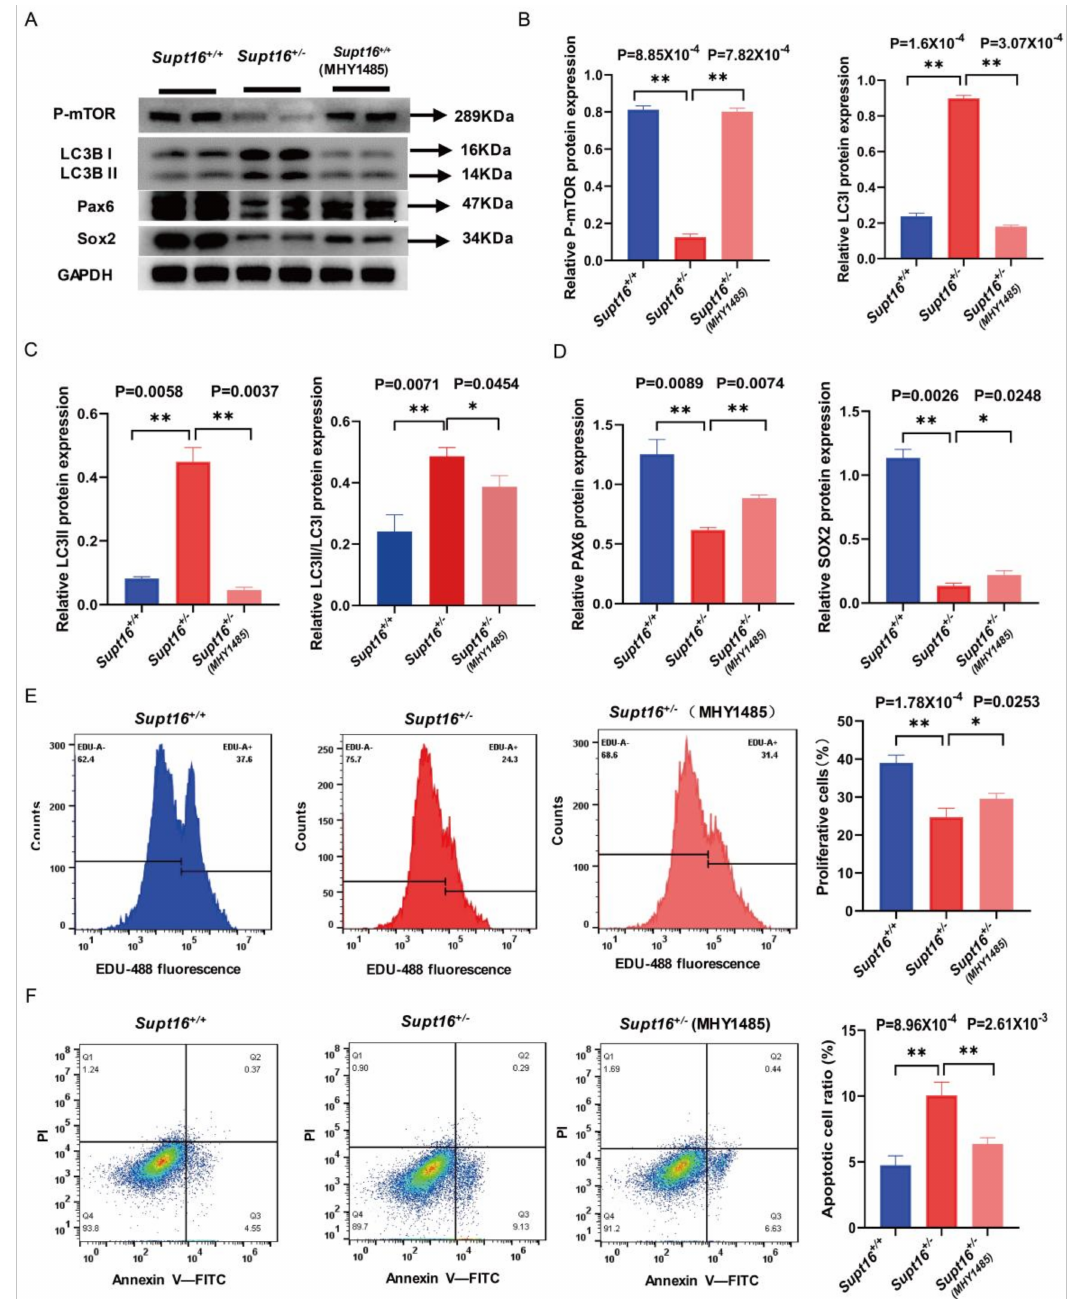
Figure 4. MHY1485 treatment rescued the phenotypes of Supt16 haploinsufficient hNSCs. ( A ) Western blot analysis showed the protein expressions of P − mTOR, LC3, PAX6, and SOX2 in hNSCs treated with different treatments. ( B ) Representative quantification analysis of P − mTOR and LC3I in